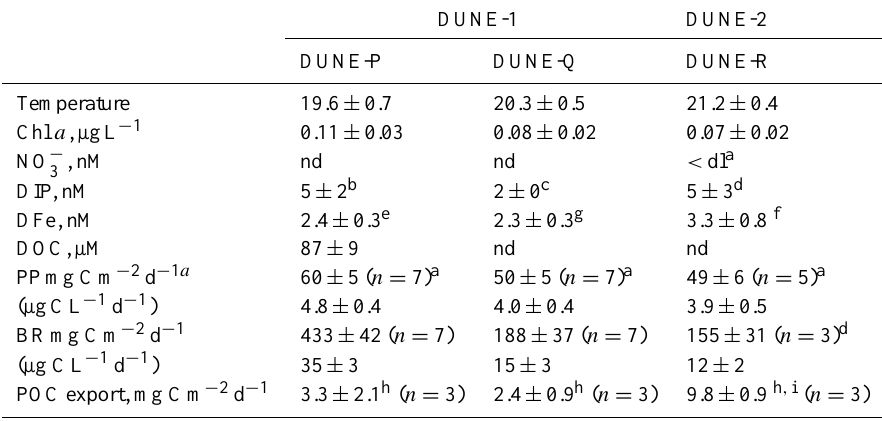
Table 1. Initial conditions of the tested waters during DUNE-P, DUNE-Q and DUNE-R experiments (all depths average in the CONTROL- MESO, DUST-MESO (before seeding), and